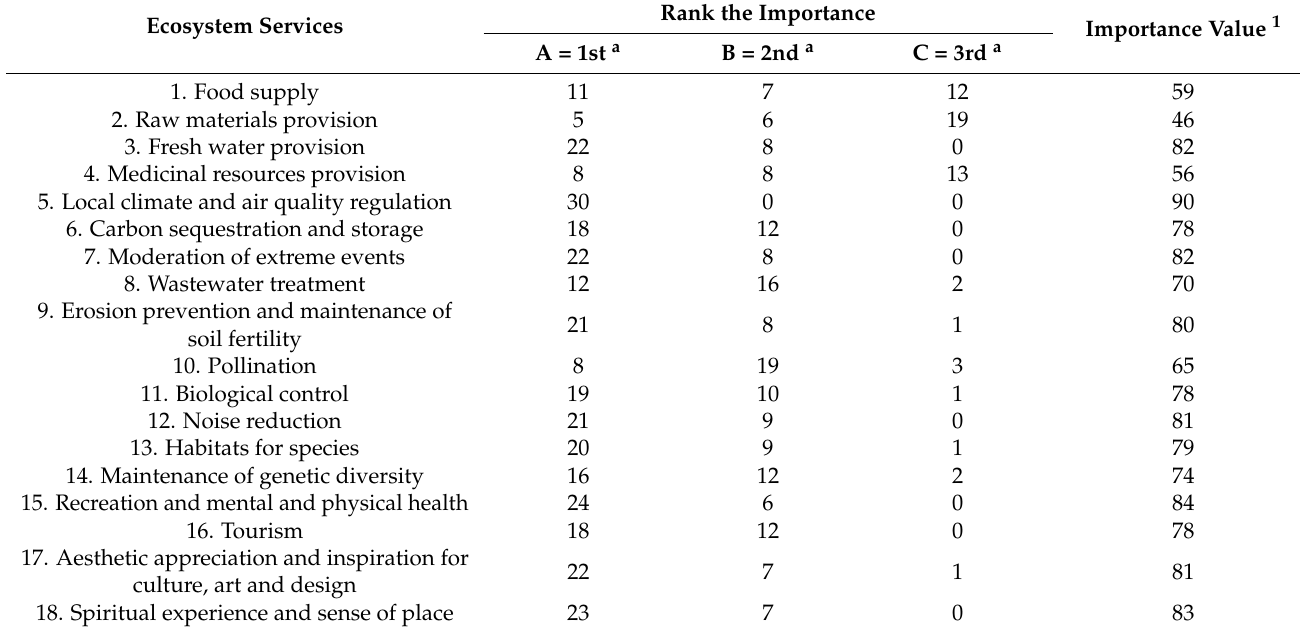
Table 1. Importance value of ecosystem services (ESs) in the first experts’ online survey. Ecosystem Services